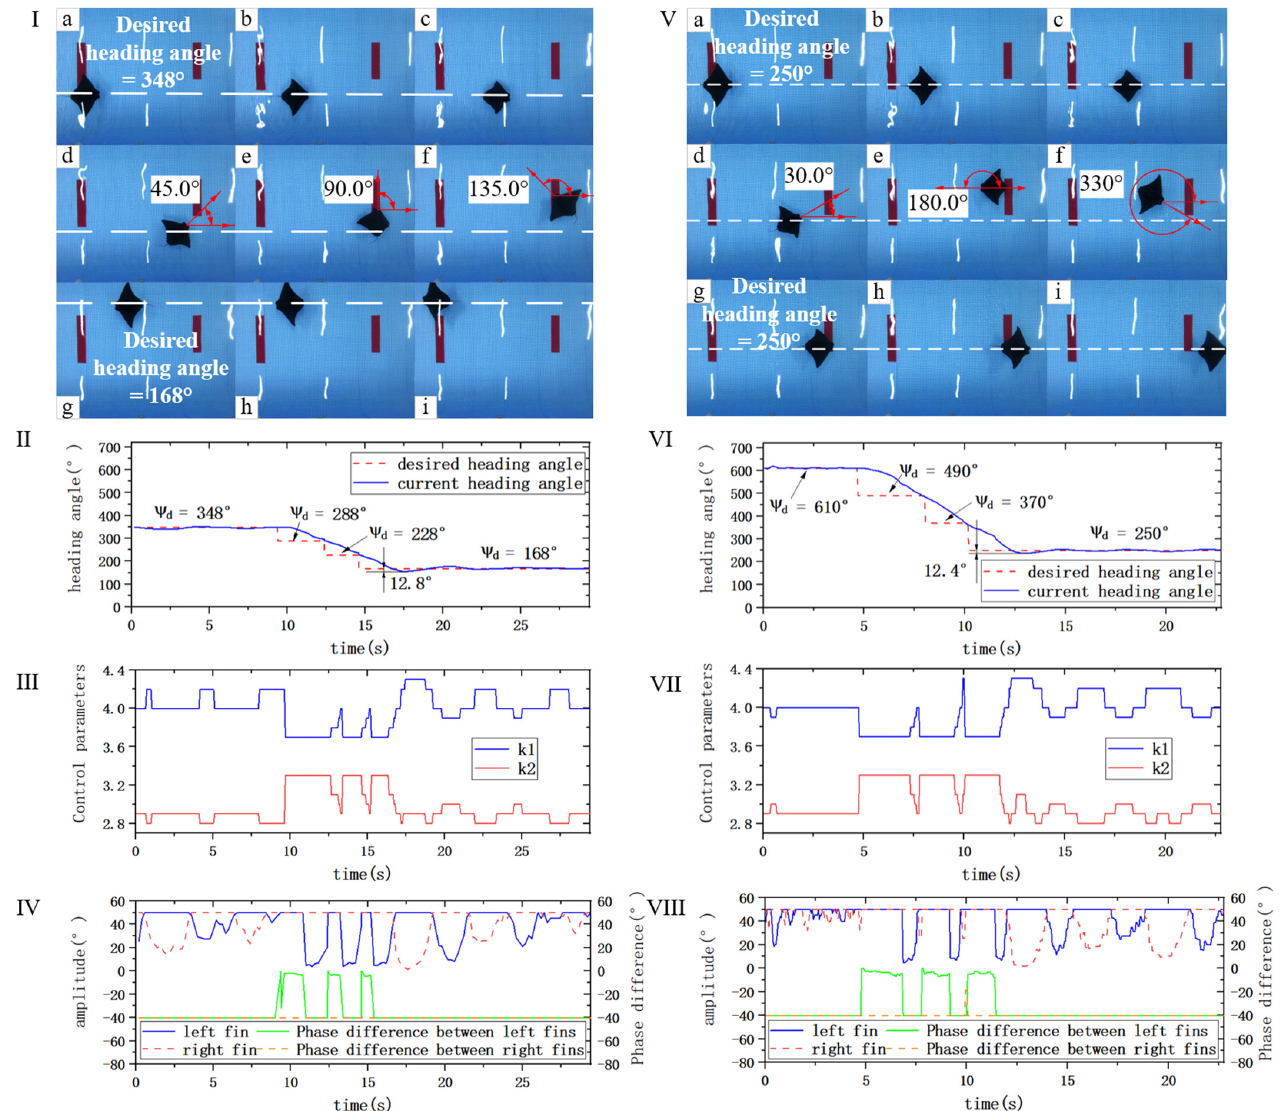
Figure 11. Heading switching of 180° and 360° experiments. ( I ) Swimming frame diagram of the manta robot with heading angle switching 180°, where (a)–(i) represents the time order. ( II ) Heading angle data graph of the manta robot with heading angle switching 180°. ( III ) Con-troller parameter change curve graph with heading angle switching 180°. ( IV ) Data plot of pectoral fin motion parameters of the manta robot with heading angle switching 180°. ( V ) Swimming frame diagram of the manta robot with heading angle switching 360°, where (a)–(i) represents the time order. ( VI ) heading angle data graph of the manta robot with heading angle switching 360°. ( VII ) Controller parameter change curve graph with heading angle switching 360°. ( VIII ) Data plot of pectoral fin motion parameters of the manta robot with heading angle switching 360°.